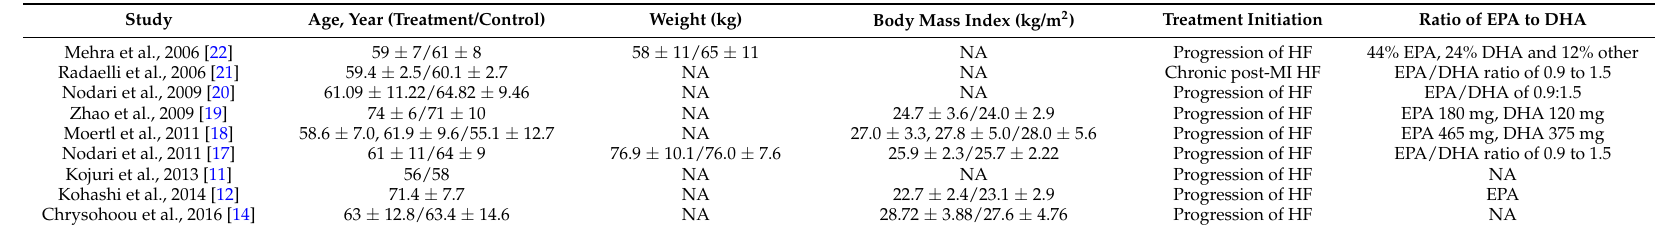
Table 2. Patient